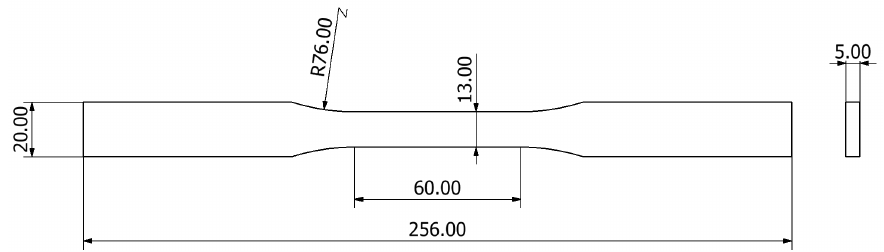
Figure 1. Tensile test specimens. Dimensions in mm.